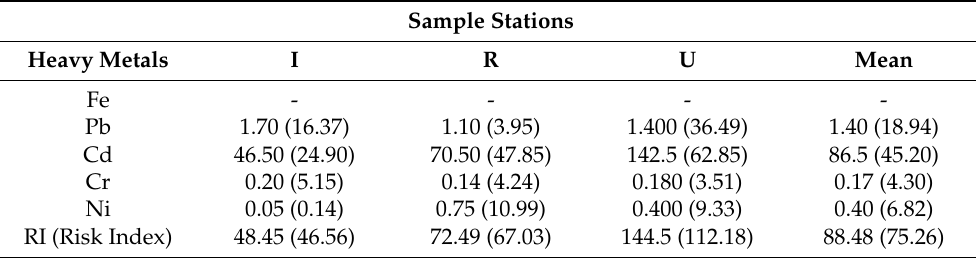
Table 11. Ecological Risk Factor ( E r F ) and Potential Ecological Risk Factor ( RI ) for the soil and Vernonia amygdalina